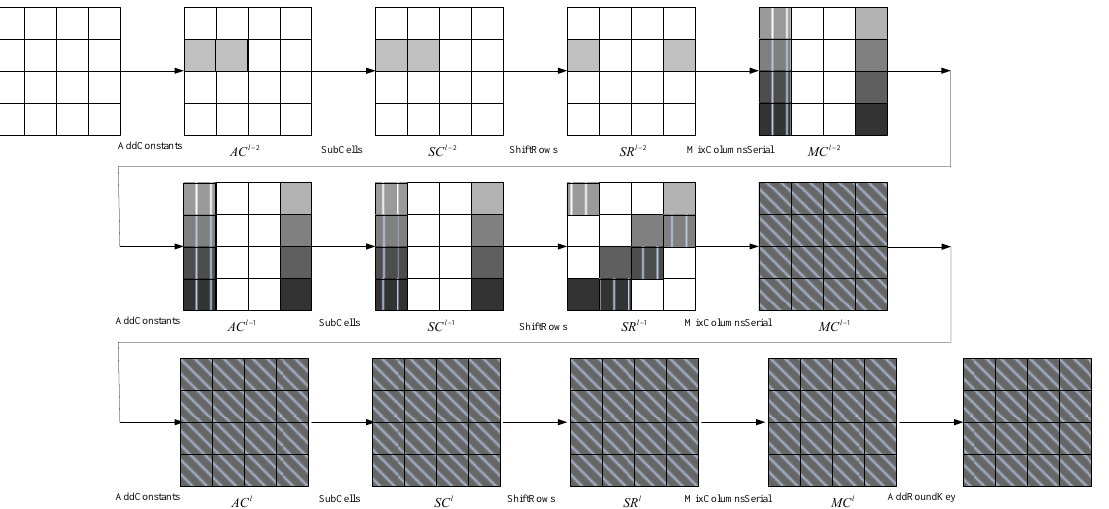
Fig. 2 One single-byte fault progagation path in the last three rounds of the LED